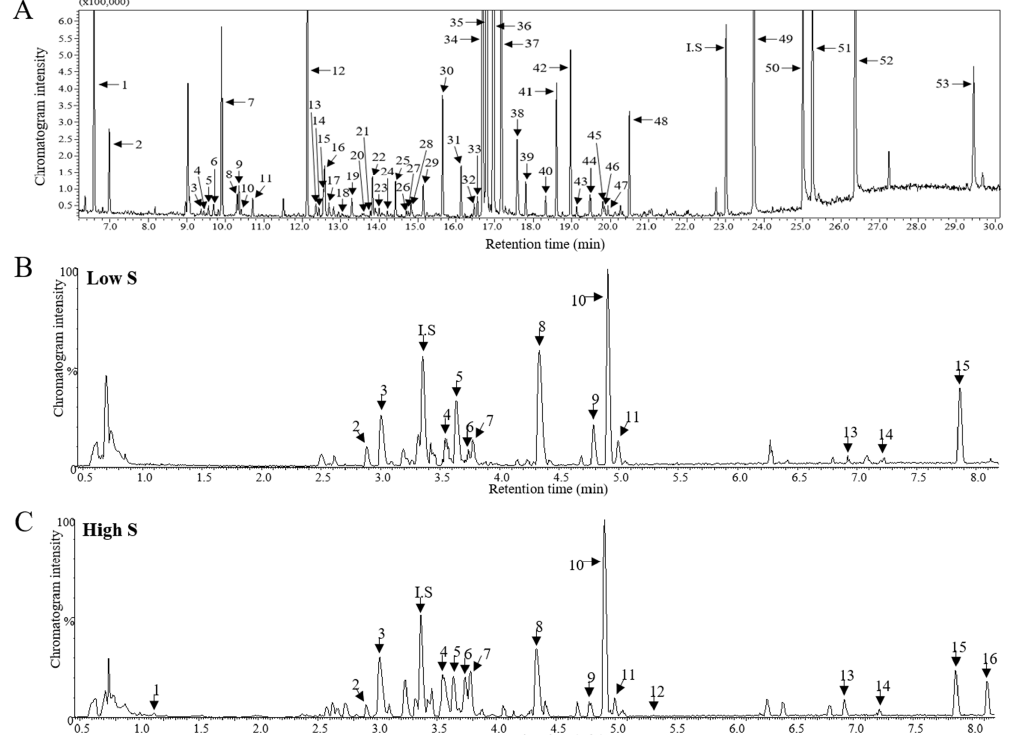
Figure 5. Representative chromatogram of metabolite profiles analyzed by GC-MS ( A ) and ultra- performance liquid chromatography-quadrupole-time-of-flight mass spectrometry (UPLC-Q-TOF